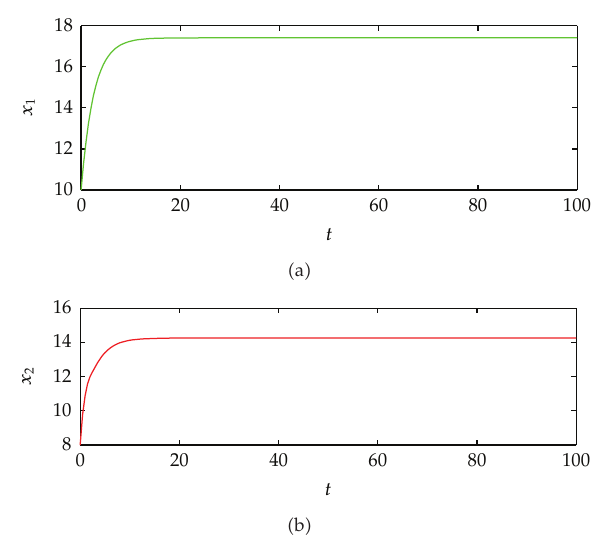
Figure 2: Dynamics of (cid:6) 4.3 (cid:7) — (cid:6) a (cid:7) time series of x 1 , (cid:6) b (cid:7) time series of x 2